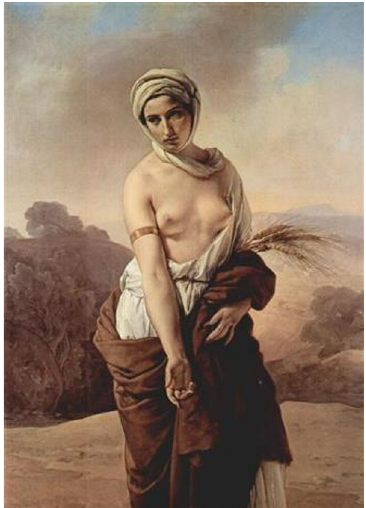
Figure 5: Francesco Hayez, Ruth , 1835.